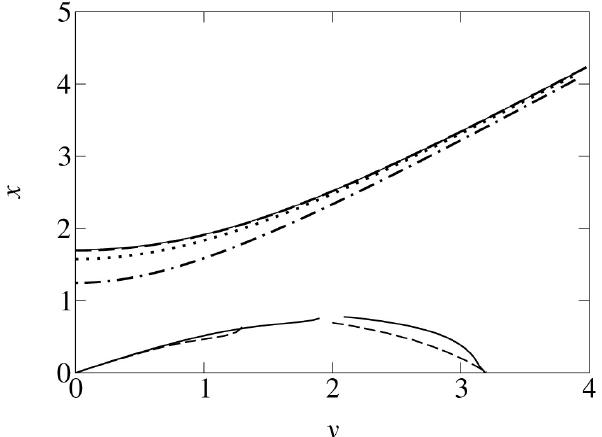
Fig. 7. Effective plasma frequency as a function of inverse normal- ized temperature µ . Solid line: fluid model. Dashed line: kinetic model.